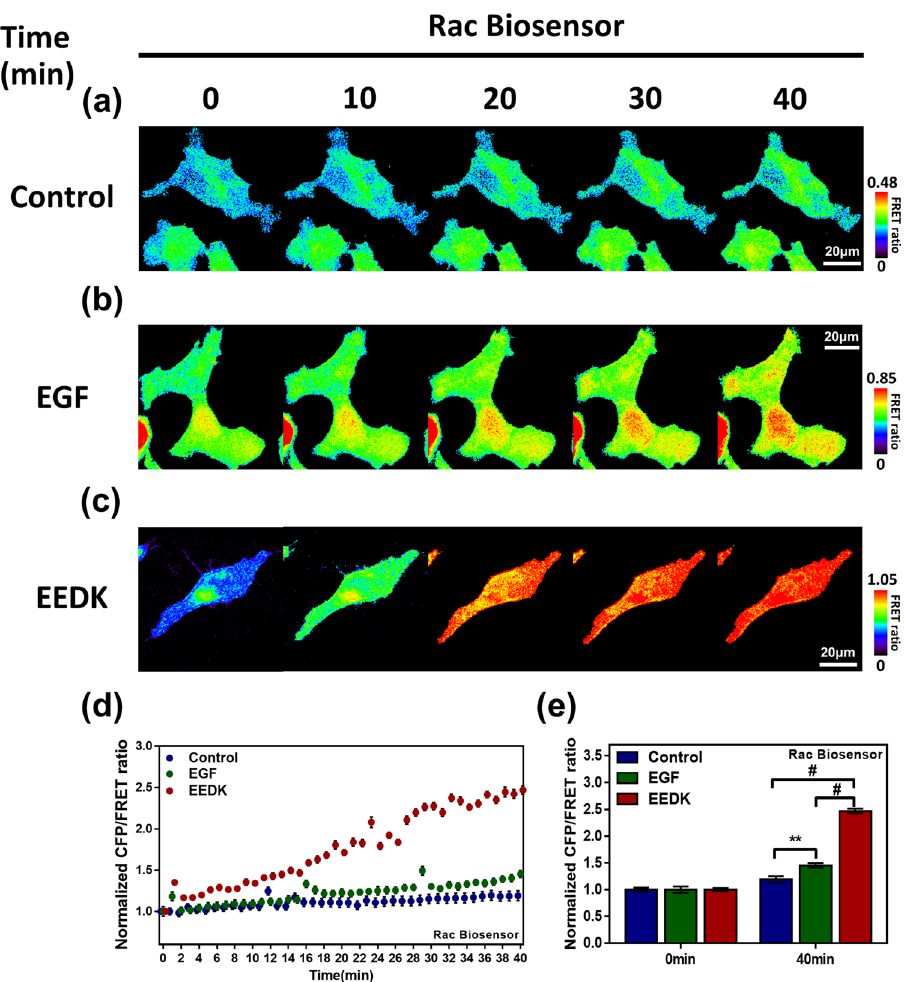
Figure 4. The effects of EEDK on Rac activity. ( a – c ) Time-lapse FRET images of the Rac biosensor in HEK293A cells exposed to control (0.5% (v/v) DMSO), EGF (100 ng/mL), and EEDK (50 μg/mL). EGF was used as a positive control. The color scale bars represent the range of the CFP/FRET emission ratio in the biosensors. Hot and cold colors indicate high and low Rac activity, respectively. Scale bar = 20 μm. ( d ) The time courses represent the average of the normalized CFP/FRET emission ratio changes of the Rac biosensor. The dots are mean values of normalized emission ratios, with error bars indicating the S.E.M (n = 8). ( e ) The bar graph describes the mean values of normalized CFP/FRET emission ratios of the biosensor at 0 min and 40 min. It also contains error bars indicating the S.E.M (n = 8, ** P < 0.01, # P < 0.0001, Student’s t